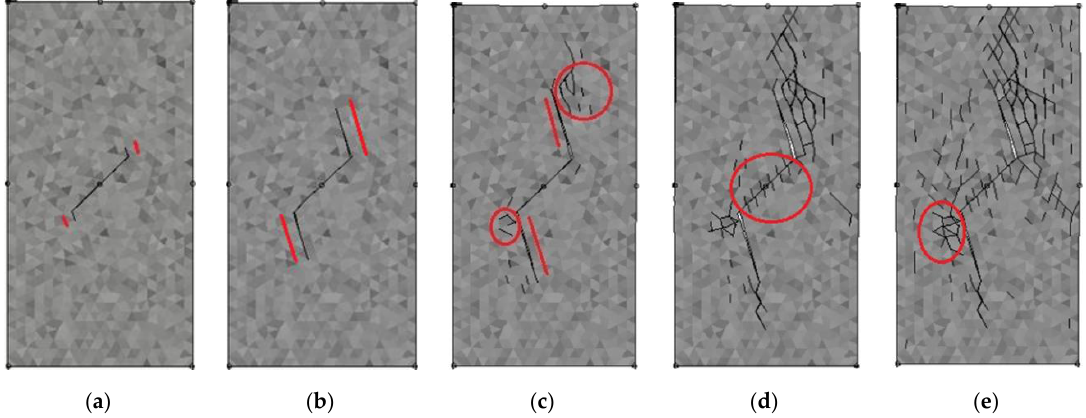
Figure 12. Failure process of Case 3 in uniaxial compression simulation experiment. ( a ) The ends of the preset joints cracked and wing cracks appeared; ( b ) Wing cracks expanded; ( c ) The width of the wing crack increased and fine cracks and some secondary joints appeared; ( d ) A group of new oblique parallel cracks appeared; ( e ) The fine cracks became connected with the wing cracks and preset joints.